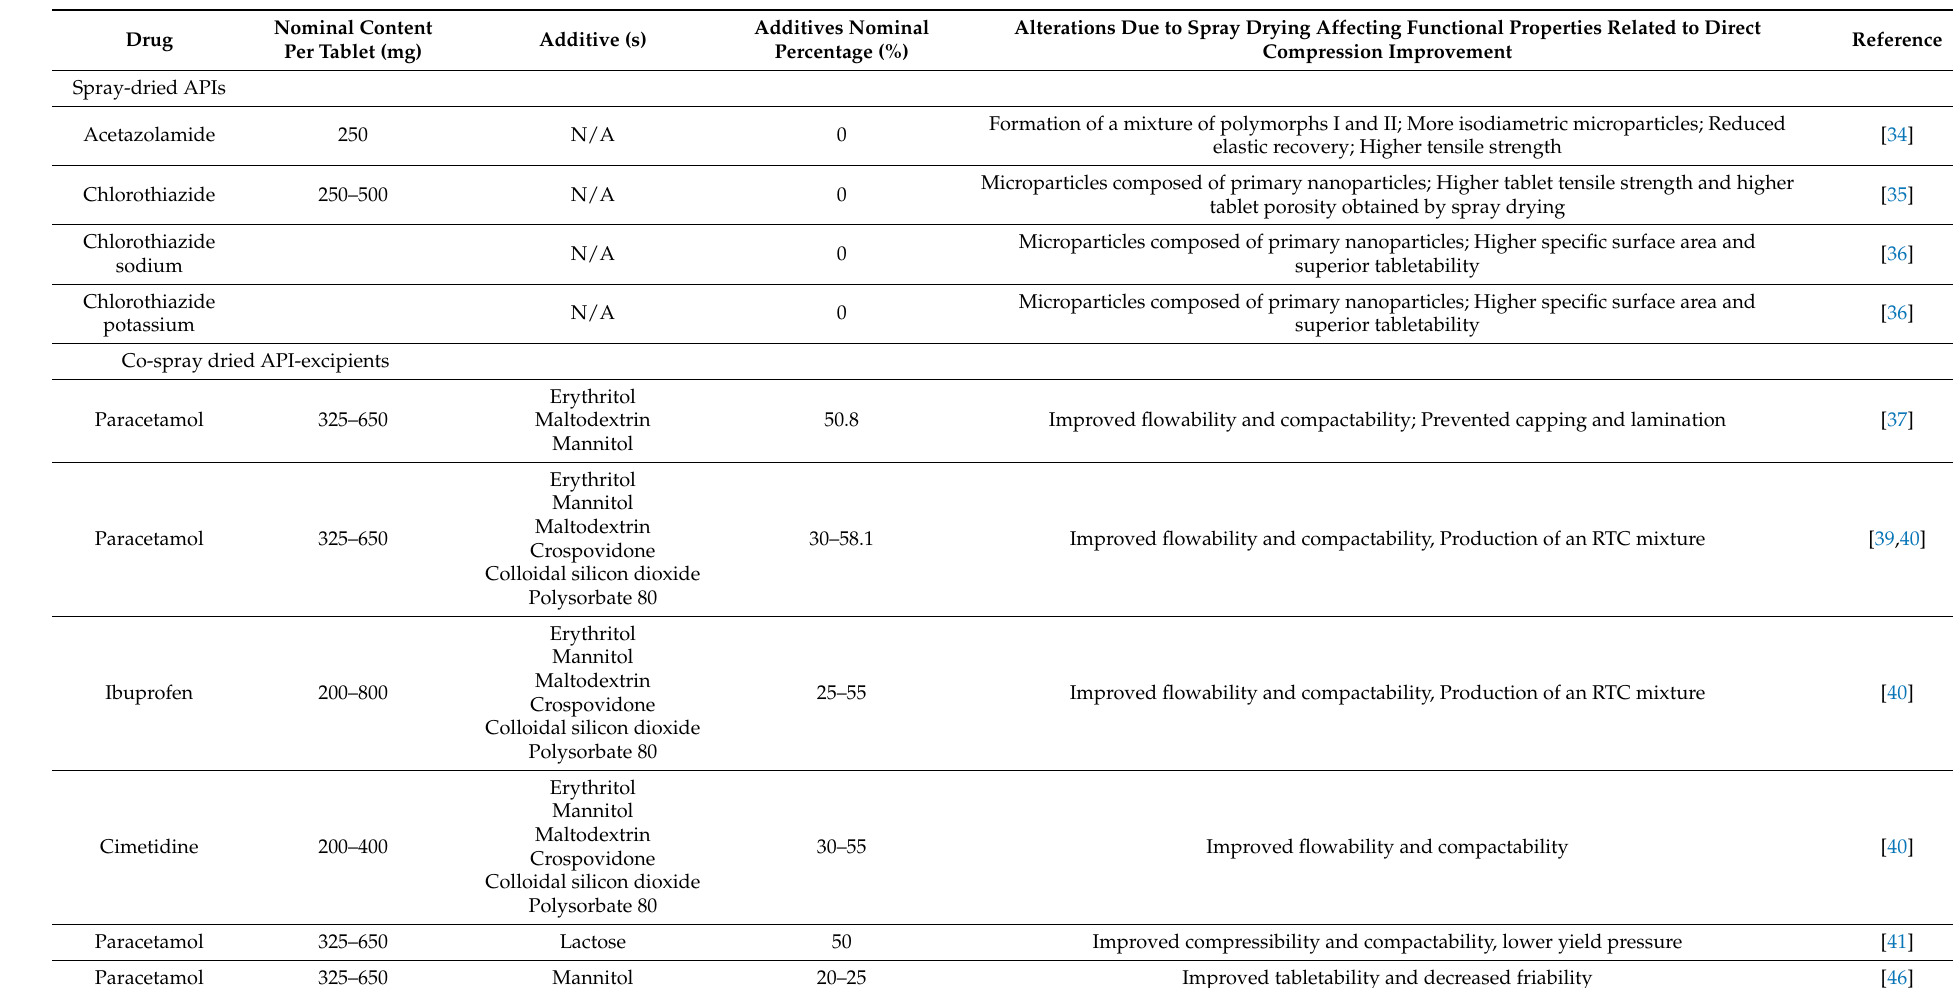
Table 1. Illustrative studies attempting direct compression of drugs by spray dying alone or with